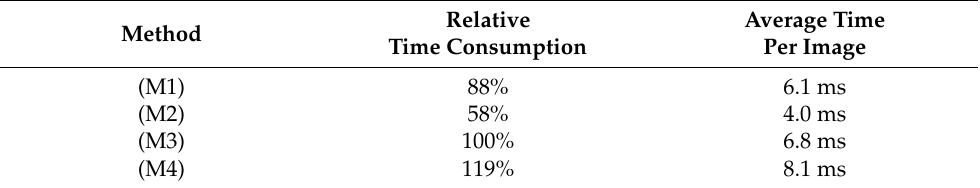
Table 3. Approximate relative time consumption of tested methods.